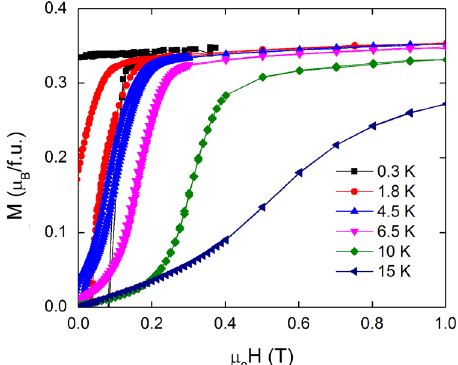
Fig. 2 Magnetization of a UCo 0.995 Ru 0.005 Al single crystal at selected temperatures measured in a magnetic fi eld applied along the c -axis